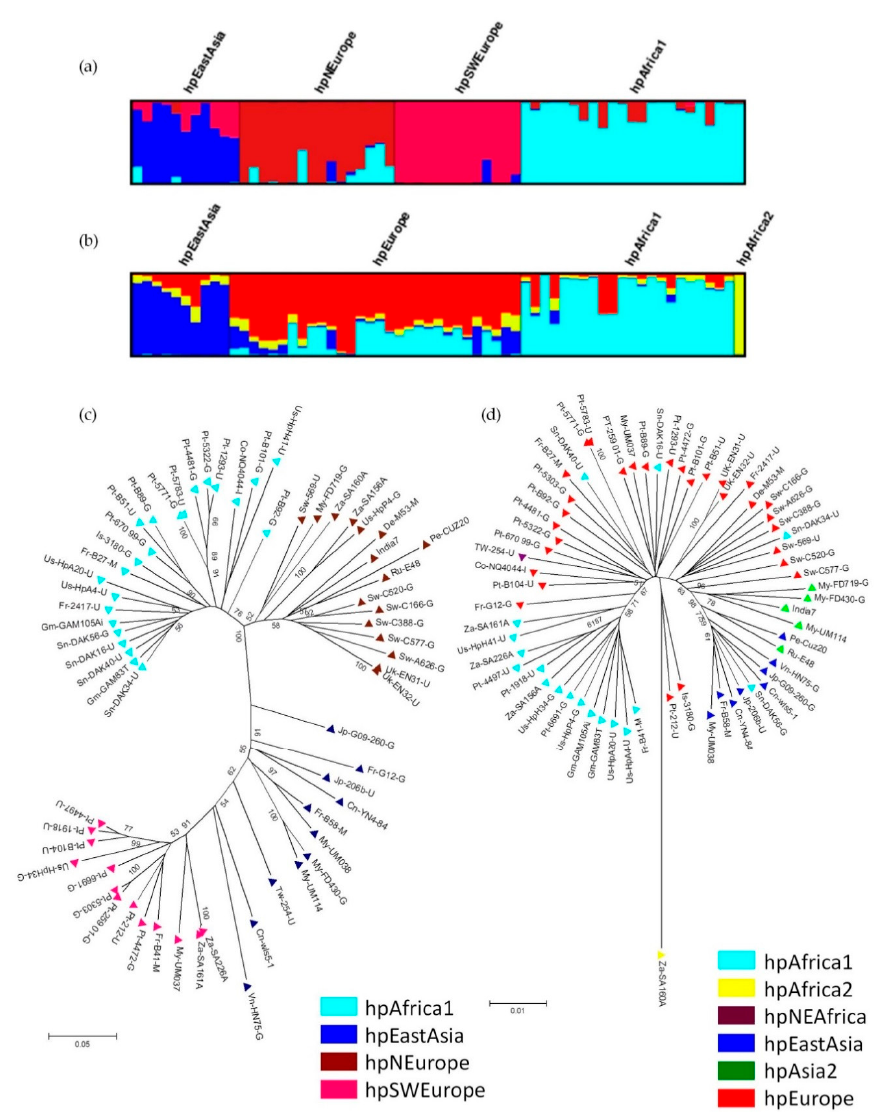
Figure 4. Population structure of H. pylori prophages: ( a ) DISTRUCT plot of Bayesian population assignments using STRUCTURE and an admixture model (K = 4) for prophages genes (PST); ( b ) Same methodology used for the sequences of seven housekeeping genes (MLST). Each bacterial isolate is depicted by a thin vertical line, which is divided into K colored segments representing the membership coefficients in each cluster; ( c ) Neighbour-joining tree (Kimura 2-parameter) of concatenated prophage sequences; ( d ) Neighbour-joining tree (Kimura 2-parameter) of concatenated sequences of MLST genes. In C and D the strains are colour-coded according to the population assignment by STRUCTURE using PST and MLST genes, respectively (adapted from [10]).